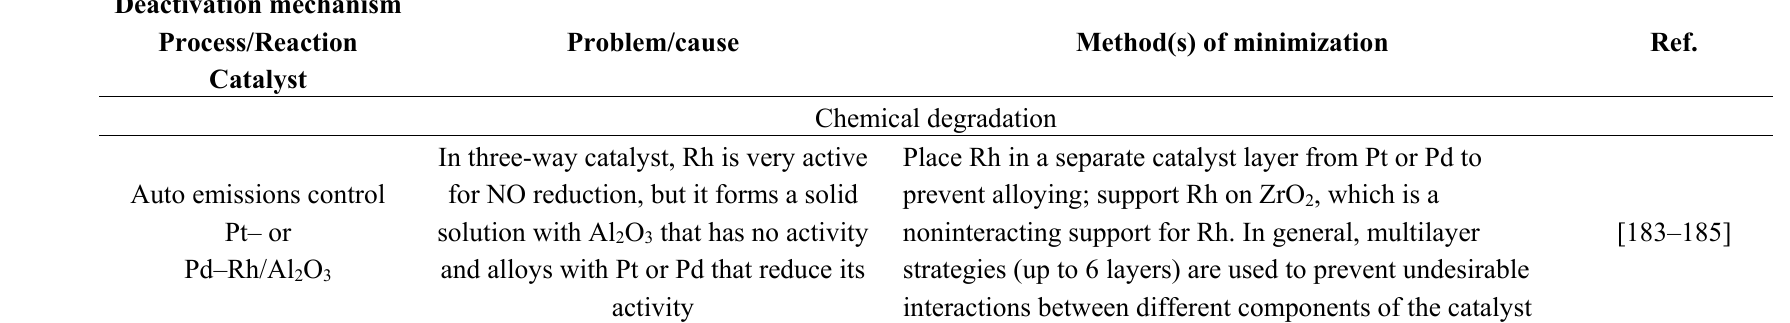
Table 19. Representative Results from Studies Focusing on Prevention/Minimization of Catalyst